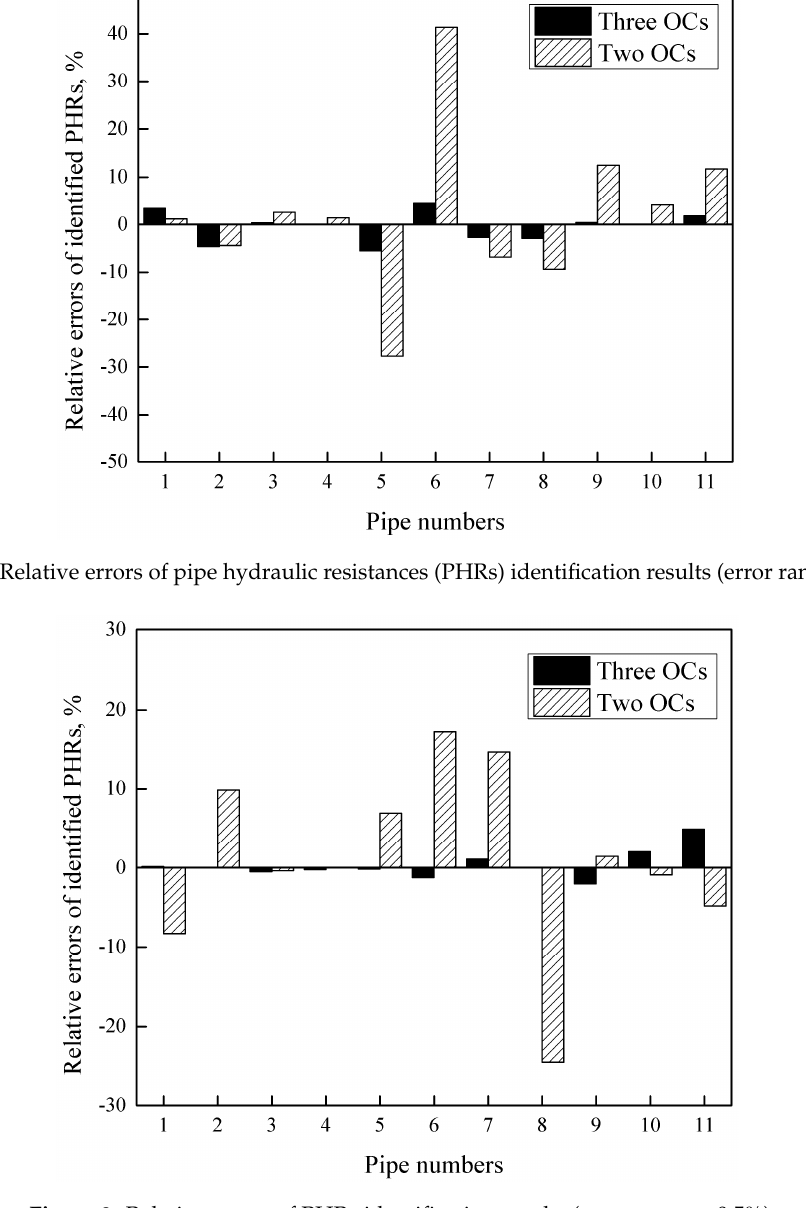
Figure 3. Relative errors of PHRs identification results (error range = 0.5%).